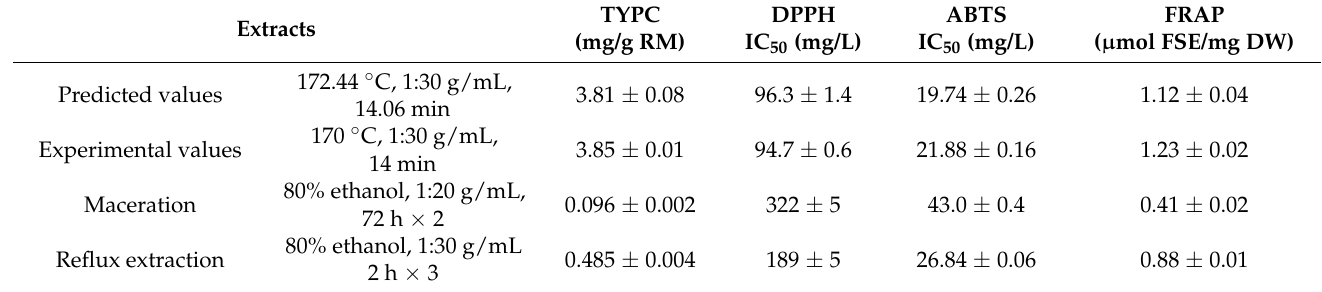
Table 5. Comparison of the TYPC and each antioxidant property between predicted values from mathematical models, actual experiment results of the optimal PHWE and conventional solvent